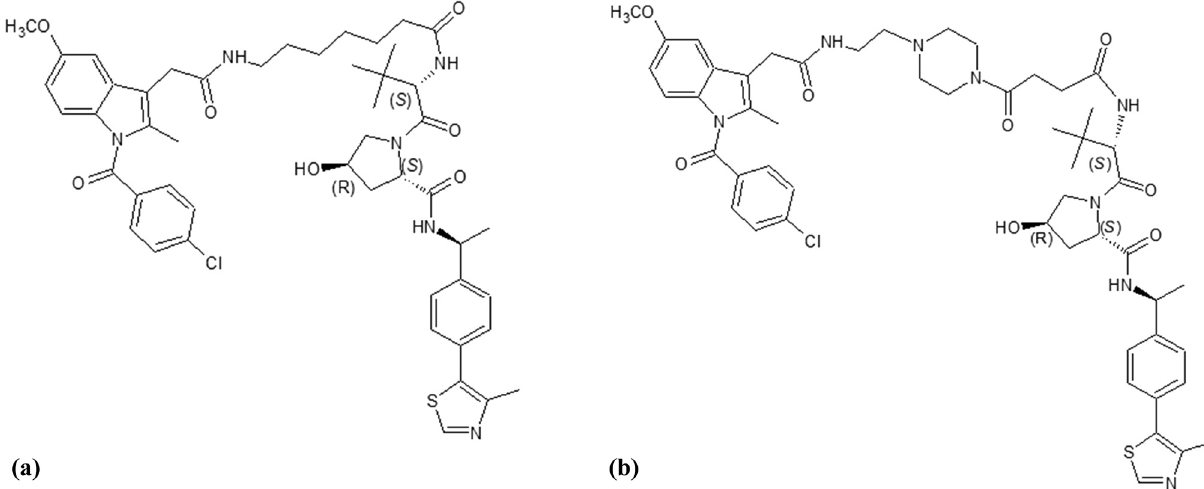
Figure 2: Structural formula of ( a ) 8 and ( b ) 9